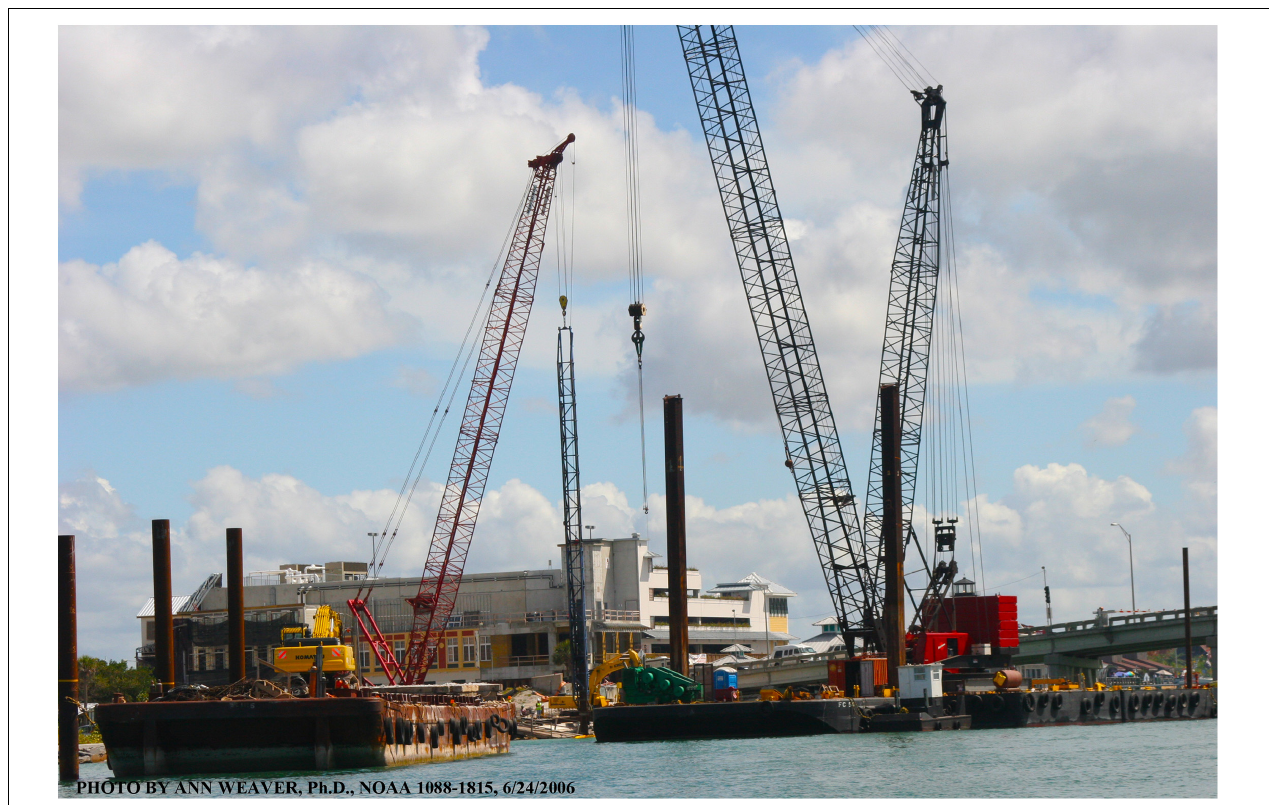
FIGURE 9 | Noise and vibrational pollution from multiple barges, tugboats, small vessels, and cranes operated throughout construction added to environmental impacts.